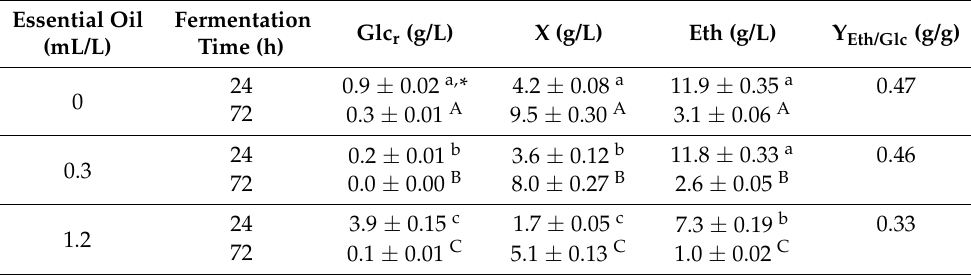
Table 3. Biomass concentration (X, g/L), ethanol concentration (Eth, g/L), and remaining glucose quantity (Glc r , g/L) at two fermentation points; the point when the maximum concentration of biomass (24) and maximum concentration of ethanol (72) was achieved. The conversion yield of ethanol produced per glucose consumed (Y Eth/Glc , g/g) is also presented at the point in which maximum ethanol concentration was